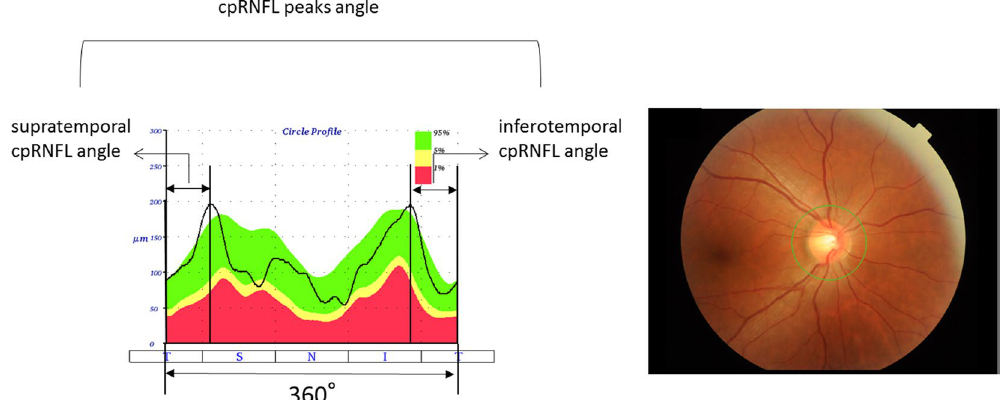
Figure 1. Calculation of cpRNFL peaks angle. The cpRNFL peaks angle was calculated as the angle between the supratemporal cpRNFL peak angle and inferotemporal cpRFNL peak angle. cpRNFL: circumpapillary retinal nerve fiber